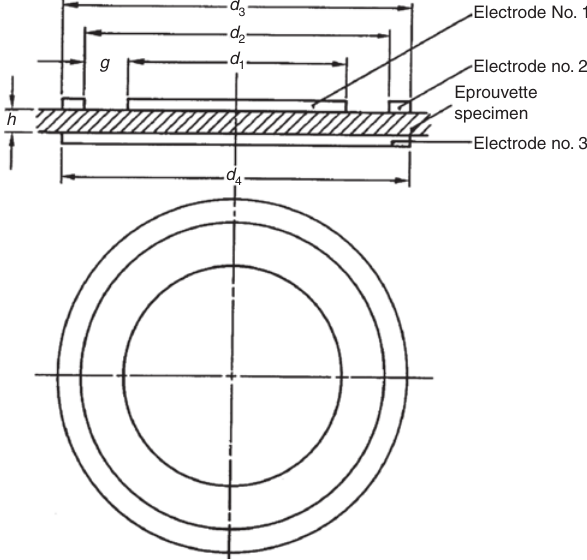
Figure 6 Volume resistivity electrode connections